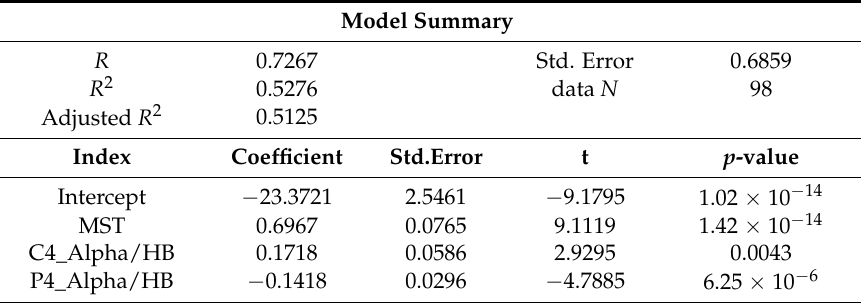
Table 2. Result of multiple regression 2 ( Yc ).